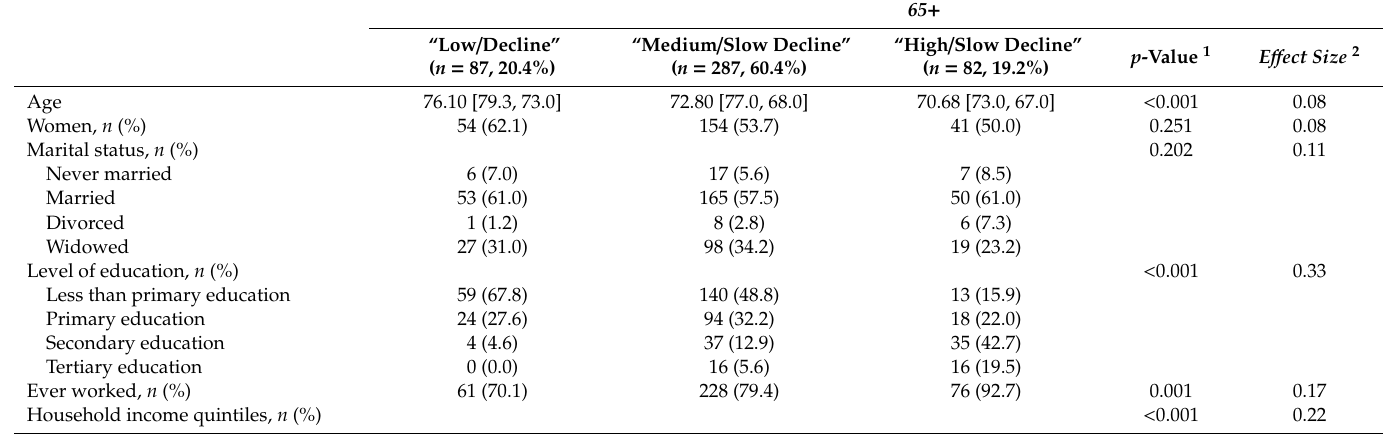
Table 4. Comparison of sociodemographic and clinical characteristics between immediate verbal memory trajectories in the 65 +